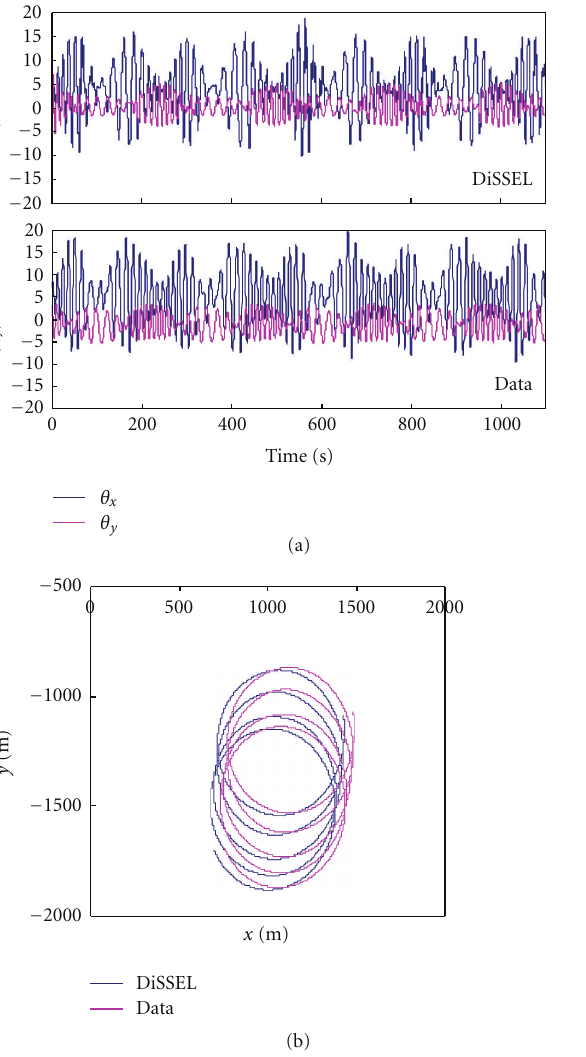
Figure 4: (a) Roll and pitch motions of EHF with δ = 30 ◦ , F r = 0 . 2146 in the regular incident wave wh = 5 . 984 m, λ = 2 . 0 (Case 3). The numerical results from the improved DiSSEL are on the top, and the experimental data are in the bottom. (b) Same as (a), but for the ship track in Earth coordinate, x is the initial direction, and y is perpendicular to x direction. (c) Same as (a), but for the driving and restoring forces